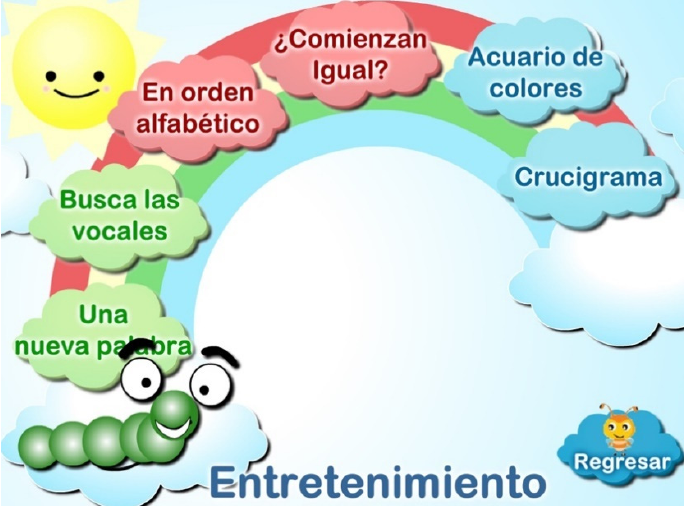
Figure 6. Options for each guided reading.